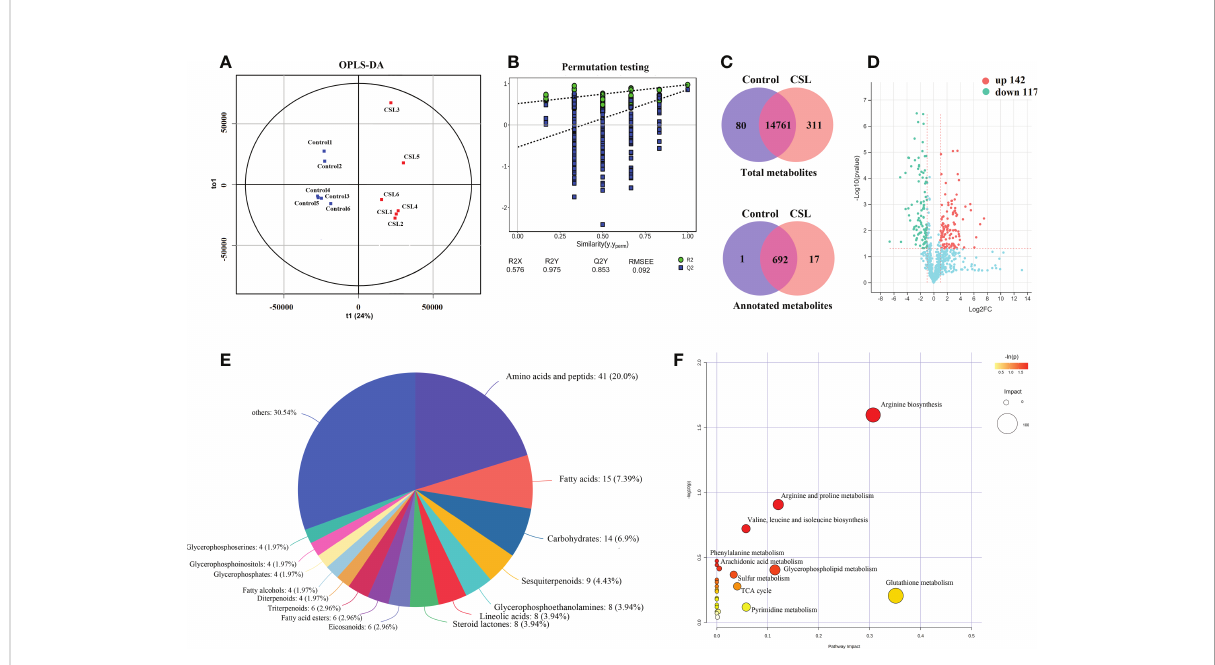
FIGURE 3 Overview of metabolomics in Codonopsis pilosula . OPLS-DA score plots (A) , OPLS-DA model permutation test (B) , Venn diagram (C) , volcano plot (D) , Classi fi cation of differential metabolites (E) , KEGG enrichment analysis of differential metabolites (F)